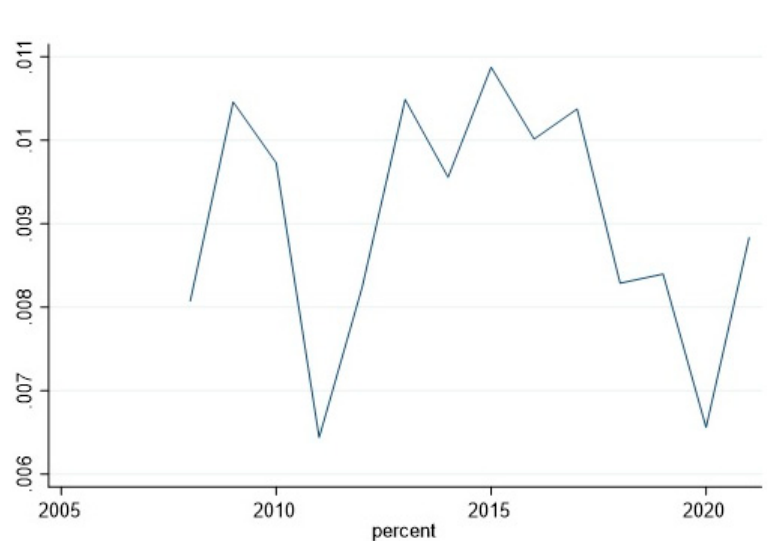
Figure A1. Dynamics of average PBR over the period of analysis. Source: Authors’ computations. Table A1. Correlation matrix.